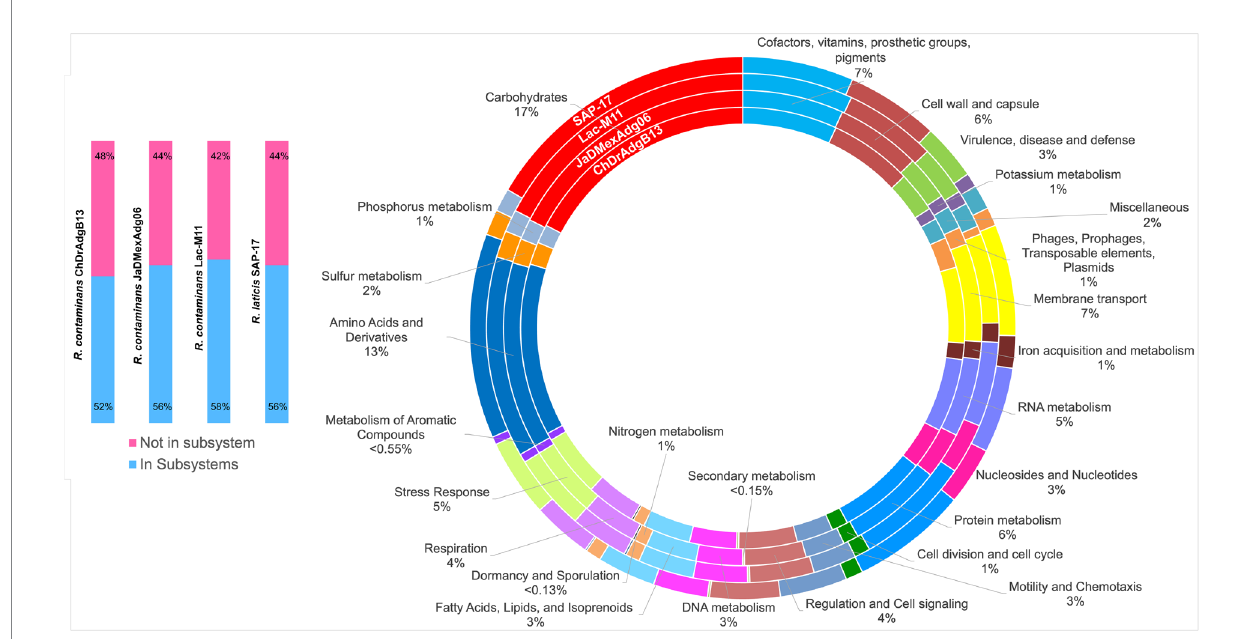
FIGURE 5 Genome features of Rahnella contaminans ecotype (ChDrAdgB13 and JaDMexAdg06 strains) and, type strains R . contaminans and R . laticis . The circles show the 26 functional categories annotated in Rapid Annotation System Technology Server. The blue color corresponds to the percentage of proteins associated with subsystems, and the pink to proteins not